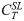
Comparison of computational model fits to data set ED1* (orange asterisks) (C0 equals 45.5).Computational model fits optimized to α equals 0.15 (blue) and α equals 0.0, subject to the constraint that CTSL is greater than say 0.5 μl/min/mm Hg (red).